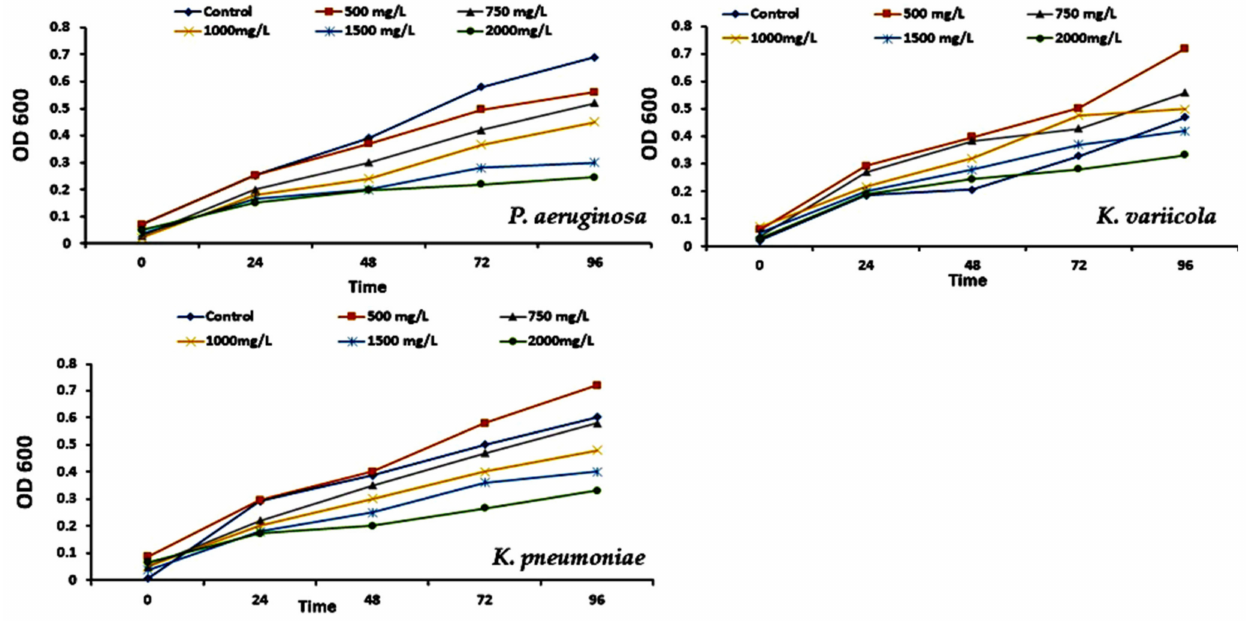
Figure 4. Effect of different phenol concentrations (0, 500, 750, 1000, 1500, and 2000 mg/L) on the growth of Pseudomonas aeruginosa , Klebsiella pneumoniae, and Klebsiella variicola